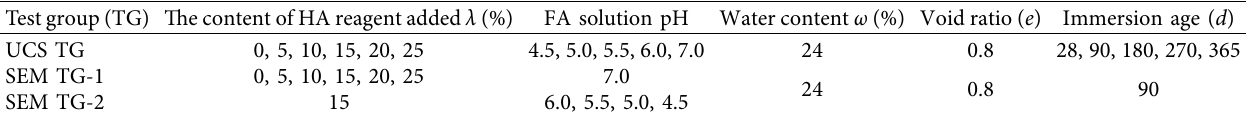
Figure 2: Sample preparation process: (a) three-part mold; (b) test sample; (c) PVC for curing. Table 2: Test conditions.